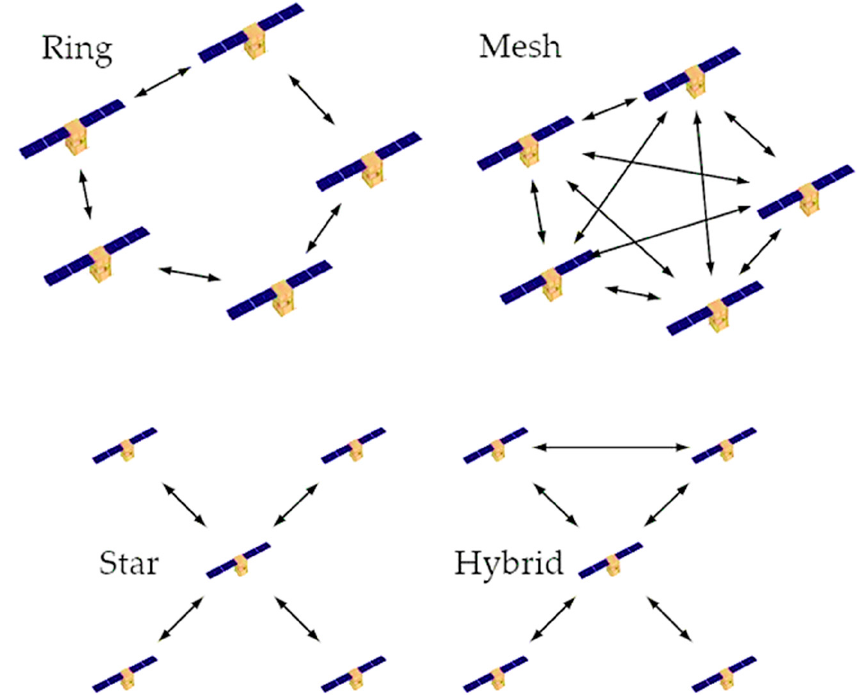
Figure 3. ISL classification [31].